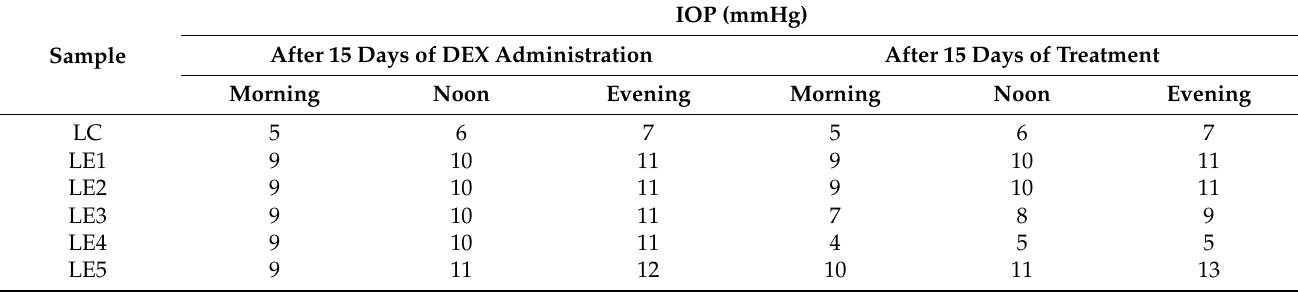
Figure 7. IOP measurement with the iCare non-contact tonometer for a rabbit from the LE4 group and its values after the administration of dexamethasone (15 days, ( A )) and after the administration of drugs encapsulated in micelles (15 days, ( B )). Table 3. Evolution of IOP values over 30